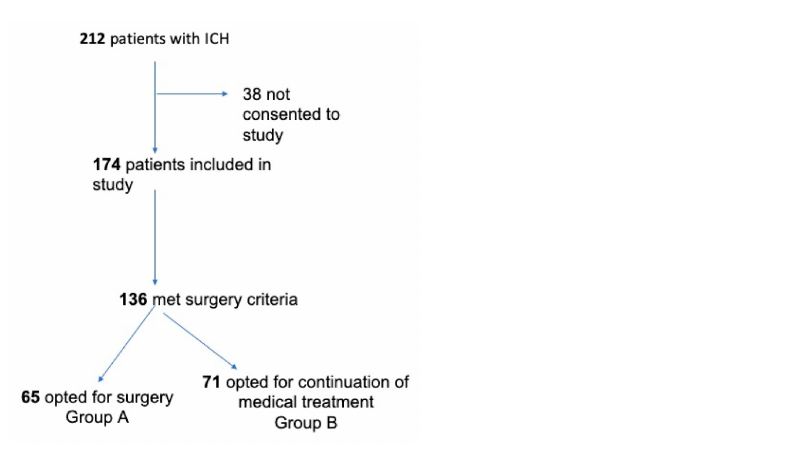
Figure 1. Inclusion criteria and the final study